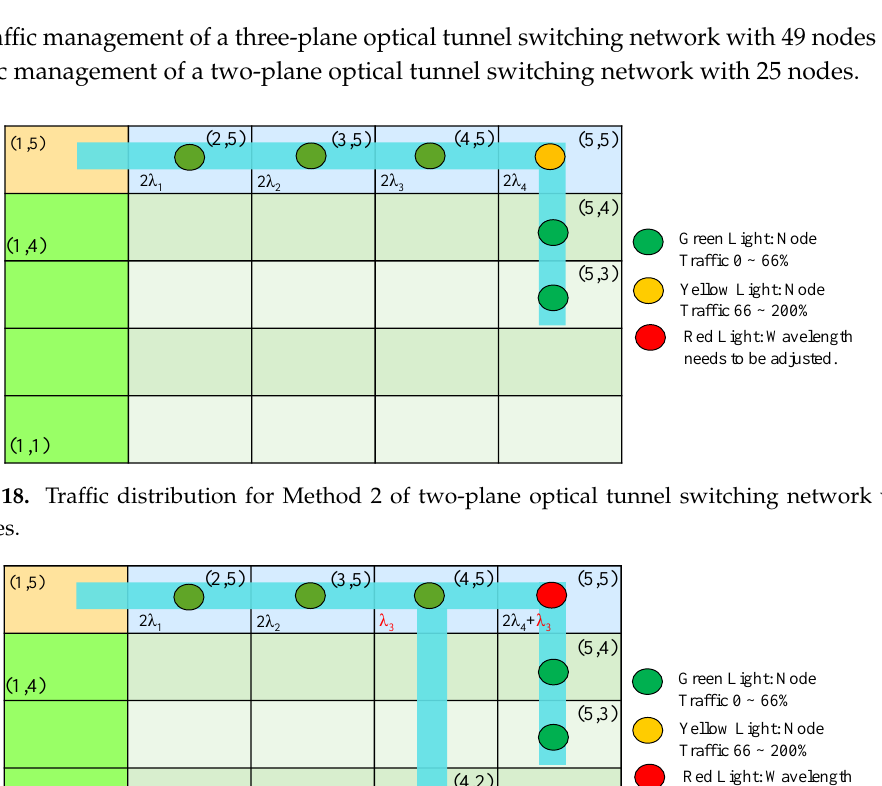
13 of 16 Figure 17. Traffic distribution for Method 1of two-plane optical tunnel switching network with 25 nodes. Figure 17 shows the traffic distribution of a two-plane optical tunnel switching network with 25 nodes. The maximum available bandwidth between any two nodes is two wavelengths, and the